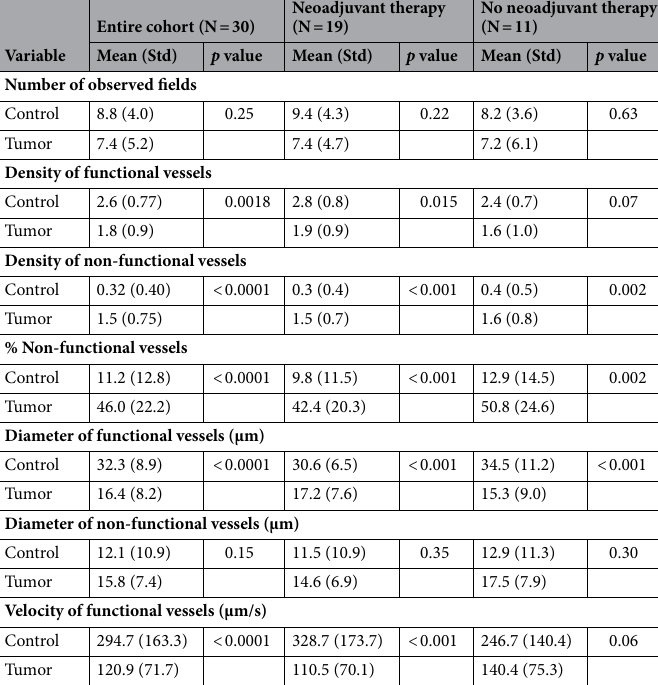
Table 2. Comparison of tumor and non-tumor (control) vessel characteristics during HIVM